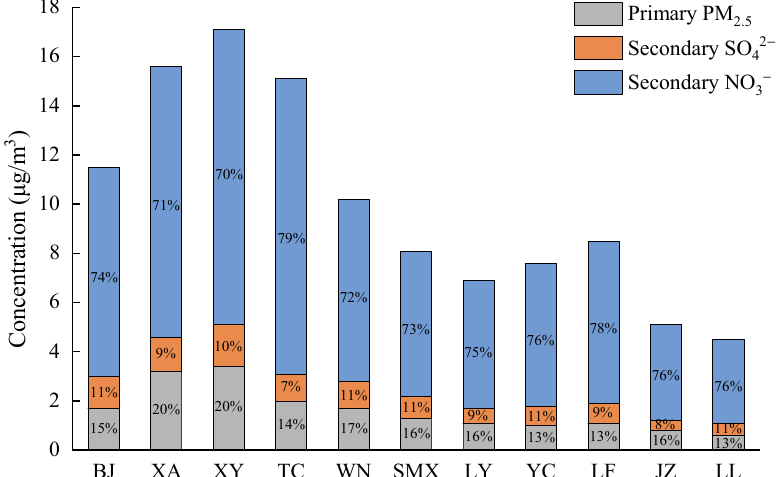
Figure 6. The hourly average of total PM 2.5 concentrations and the proportion of primary and secondary PM 2.5 in cities in the FWP.